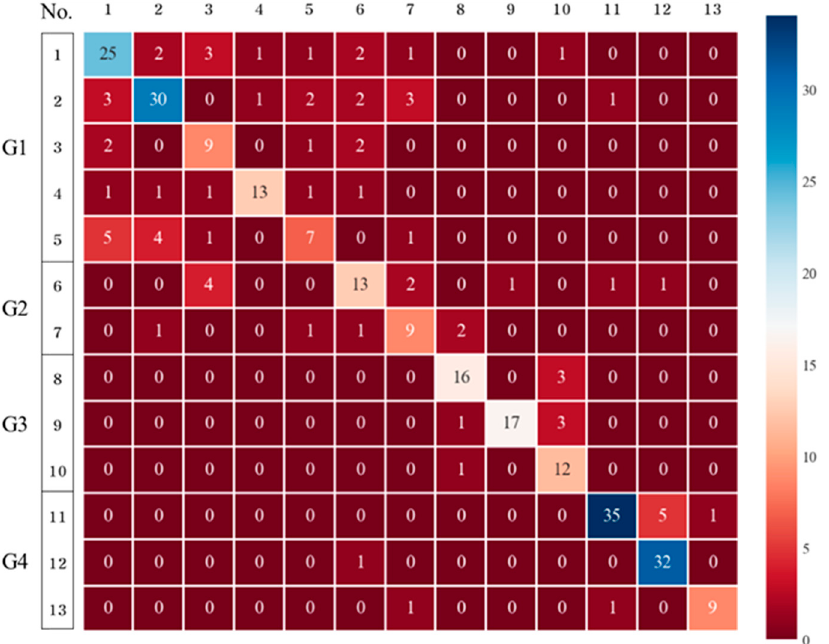
Figure 7. Confusion matrix (classi fi cation of the 13 chemicals using XGBoost) .